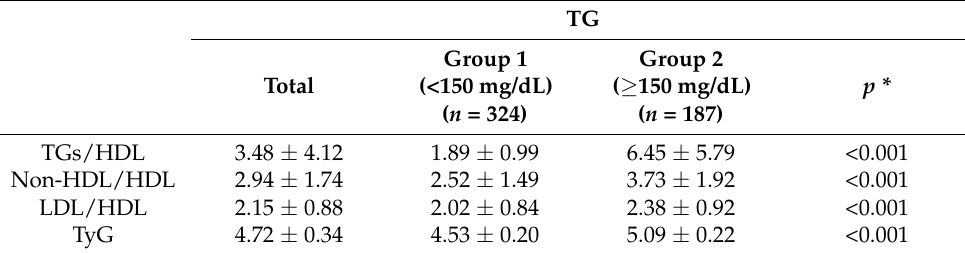
Table 2. Lipid ratio analysis for the TG groups.